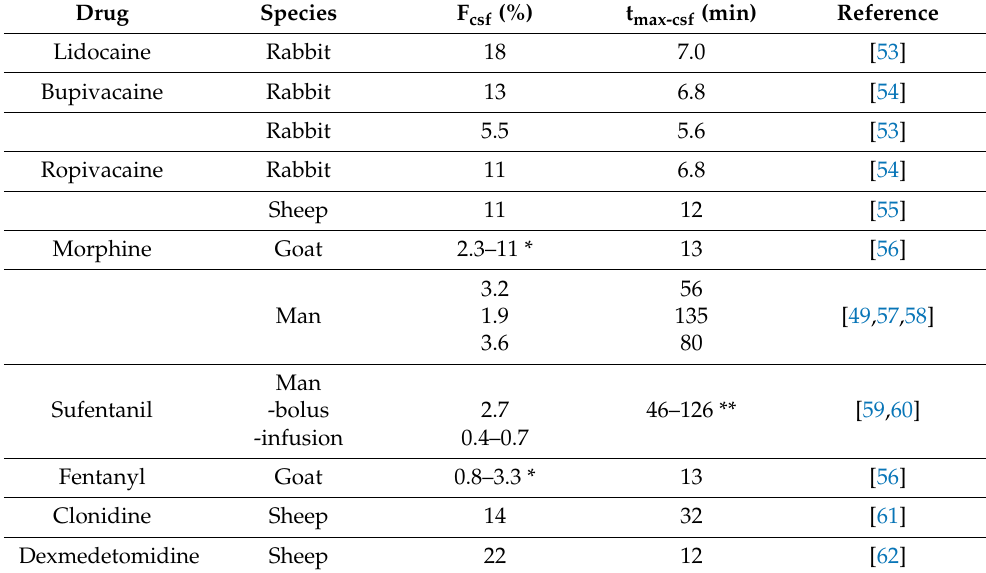
Table 1. Cerebrospinal fluid (CSF) bioavailability of local anaesthetics, opioids and α -2 adrener- gic agonists after epidural administration. F CSF , CSF bioavailability; t max-csf , time to maximum concentration in